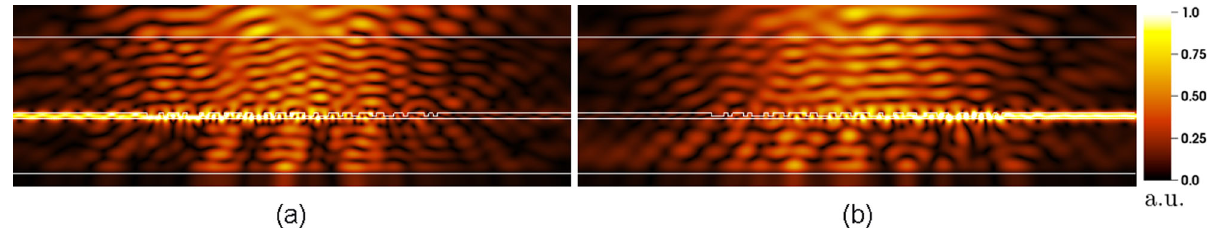
Fig. 3 Simulation of vertical incident fi eld coupling into the left and right waveguides. Electric fi eld magnitudes in the GCWD (grating coupler wavelength demultiplexer) for 1300 and 1550 nm incident excitations. a z -component E z of the electric fi eld at 1300 nm. b E z fi eld component at 1550 nm. The white lines in these fi gures correspond to interfaces separating the various material regions (Air, Passivation, Silicon, Buried Oxide, and Silicon Substrate) as illustrated in Fig.